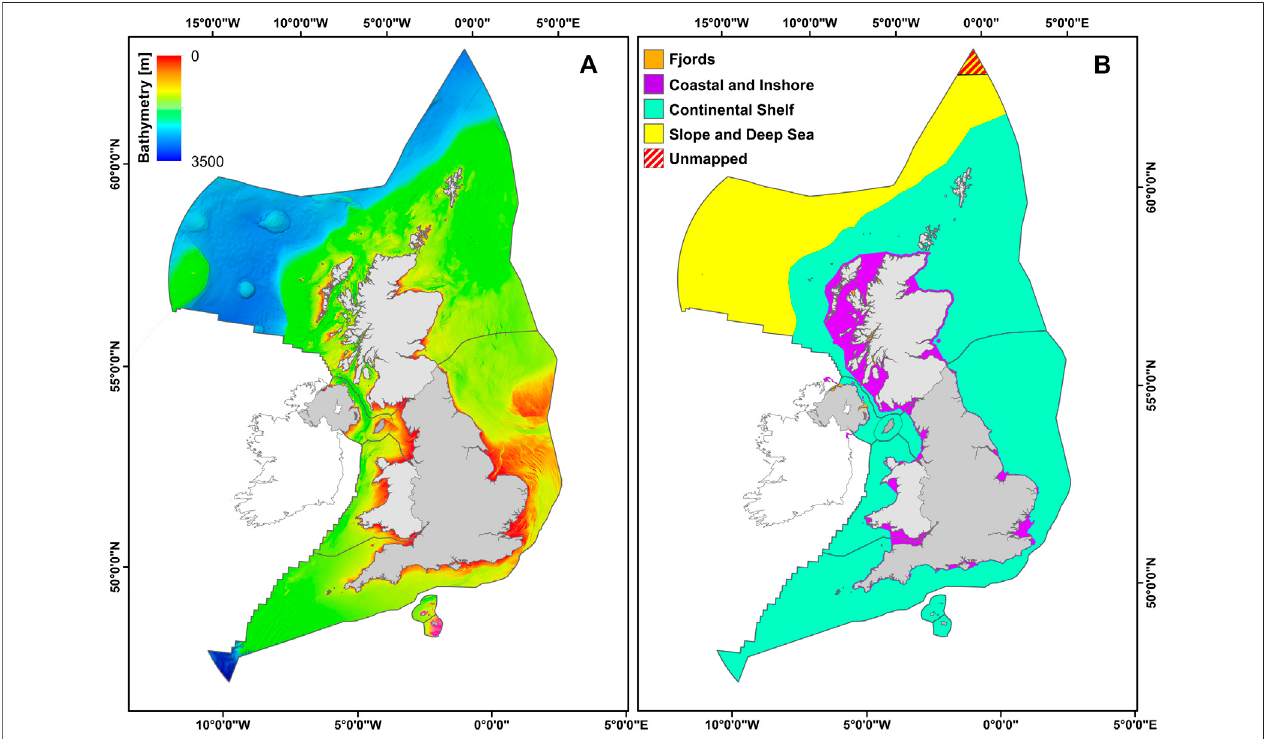
FIGURE 1 | Extent of the United Kingdom ’ s Exclusive Economic Zone with each of the areas monitored and managed by the United Kingdom ’ s four administrations and Crown Dependencies differentiated by the thin black line (A) Seabed bathymetry ( accessed through EMODnet-Bathymetry ) (B) Colored zones differentiate marine regions used to quantify and map national OC stocks.